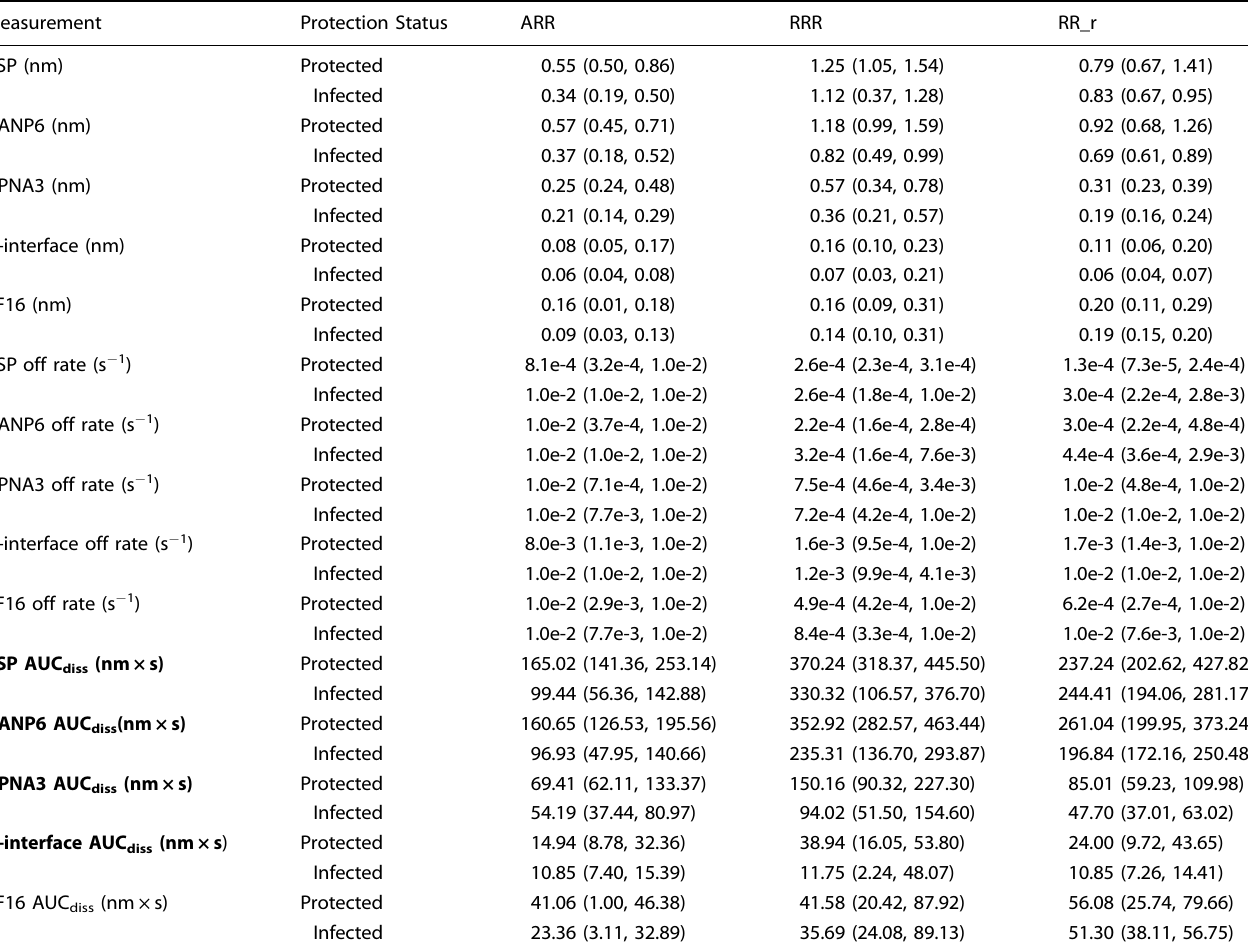
Table 3. Descriptive statistics for serum measures in RTS,S/AS01 vaccinees from MAL-068 and MAL-071 studies.